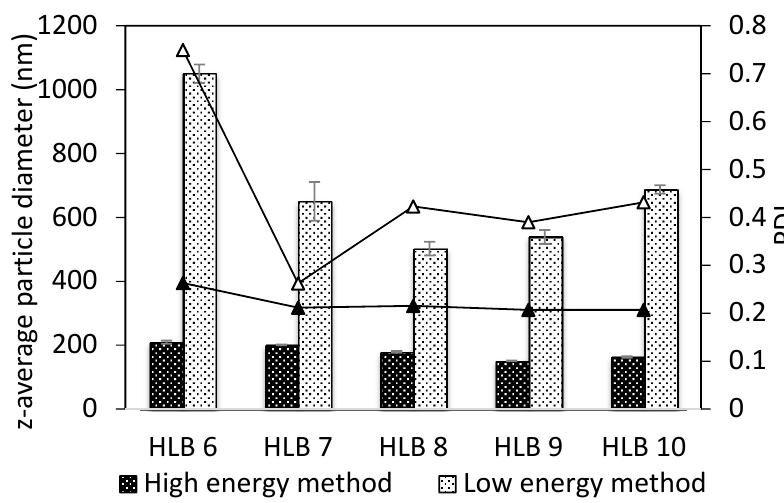
Figure 3. The influence of the HLB on particle sizes (columns) and polydispersity index (lines) of the nanoemulsions (5 wt % Tween 80/Span 80) prepared by the low-energy and high-energy methods using refined oil.